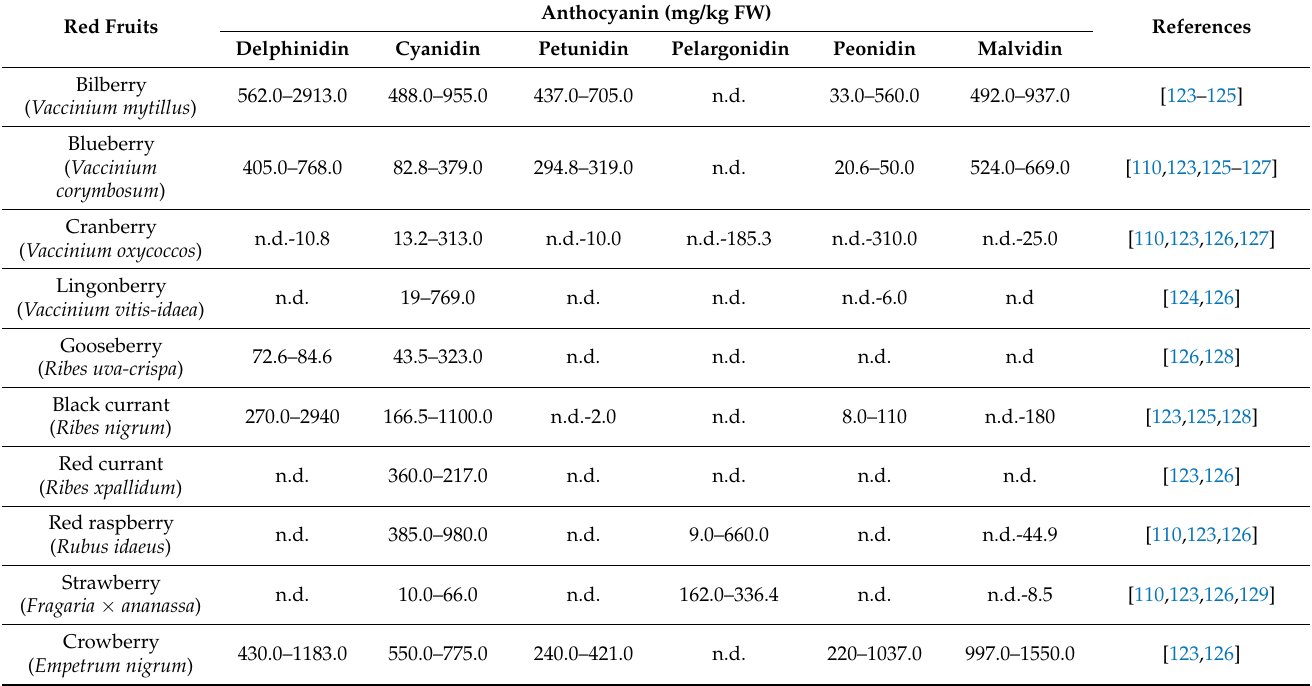
Table 10. Example of anthocyanin contents found in the most common red